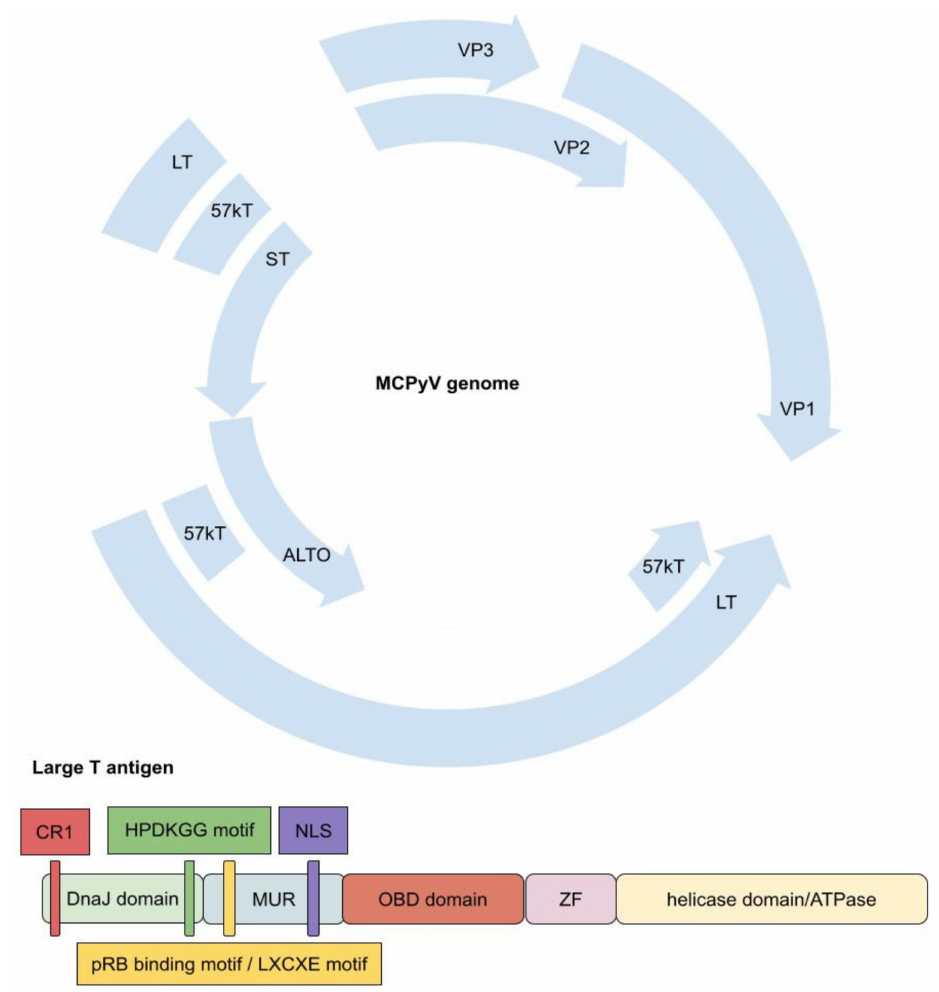
Figure 3. MCPyV genome and large T antigen structure. MCPyV genome consists of early and late regions. The late region comprises viral coat proteins VP1 and VP2, while the presence of VP3 is questionable. The early region encodes large T antigen (LT) and small T antigen (ST). When the early region undergoes alternative splicing, it produces 57kT. Moreover, in the process of the alternative translation initiation, an alternative frame of the large T open reading frame (ALTO) is expressed. Large T antigen consists of an N-terminal DnaJ domain, an MCPyV unique region (MUR), a DNA origin binding domain (OBD), the zinc finger domain (ZF), and a helicase domain/ATPase. The N-terminal DnaJ domain comprises a CR1 (conserved region 1) motif and an HPDKGG motif. MUR contains an LXCXE motif (pRB binding motif) and a nuclear localization signal